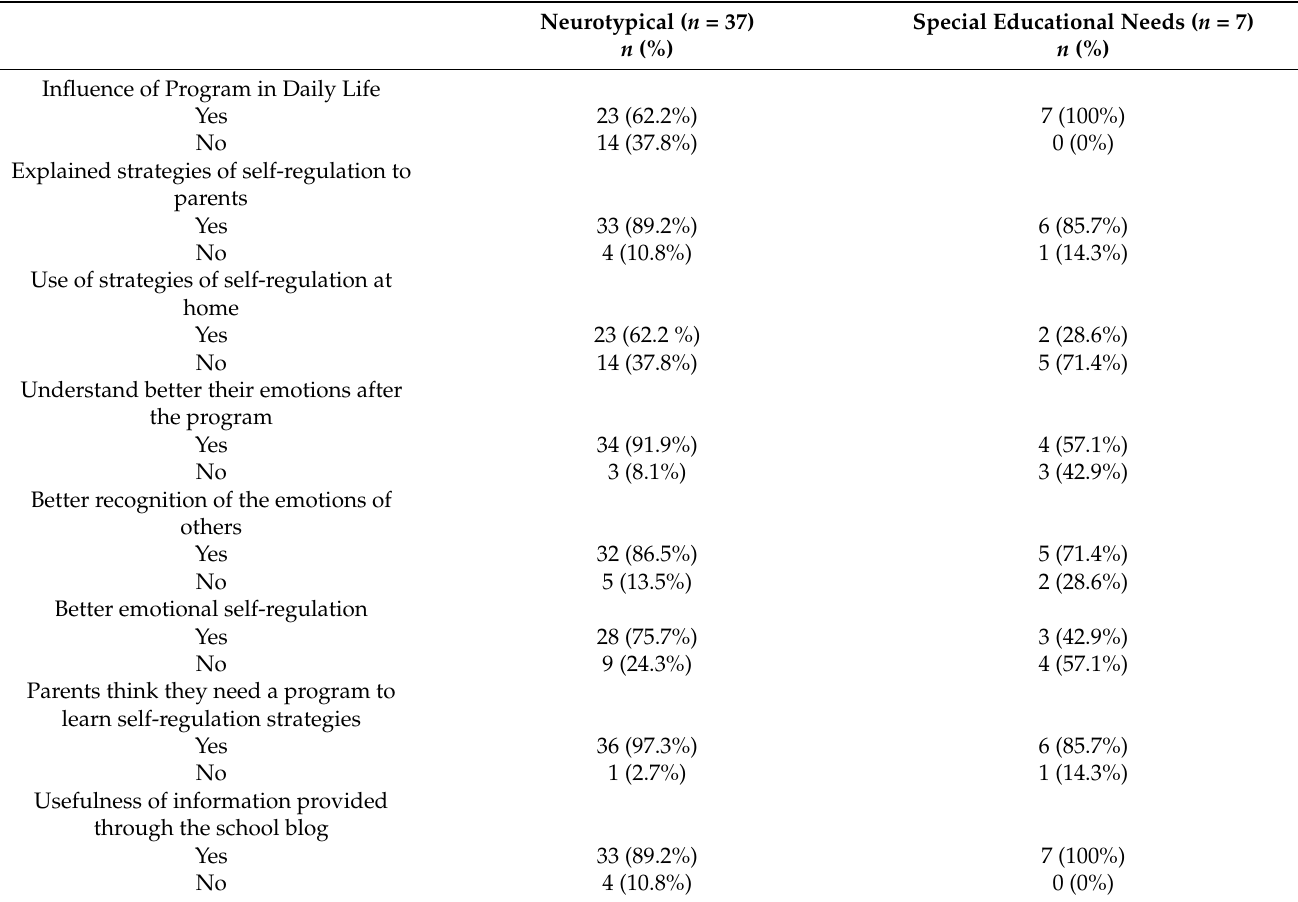
Table 4. Parent’s perception of the effectiveness of the “Exciting School” program ( n =